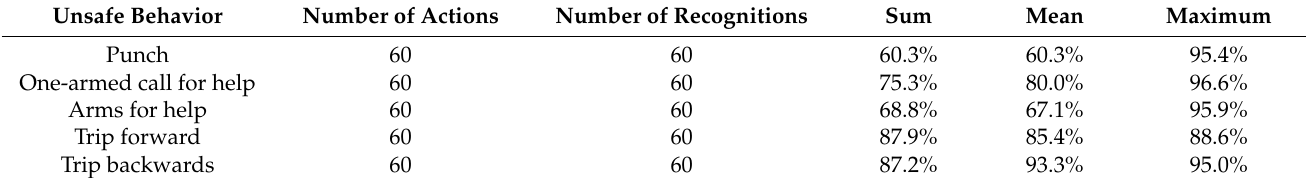
Table 8. Overall “pelvis divergence method” identification results.